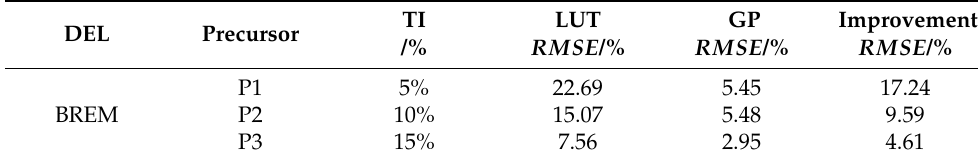
Table 4. RMSE error of blade root edgewise moment.